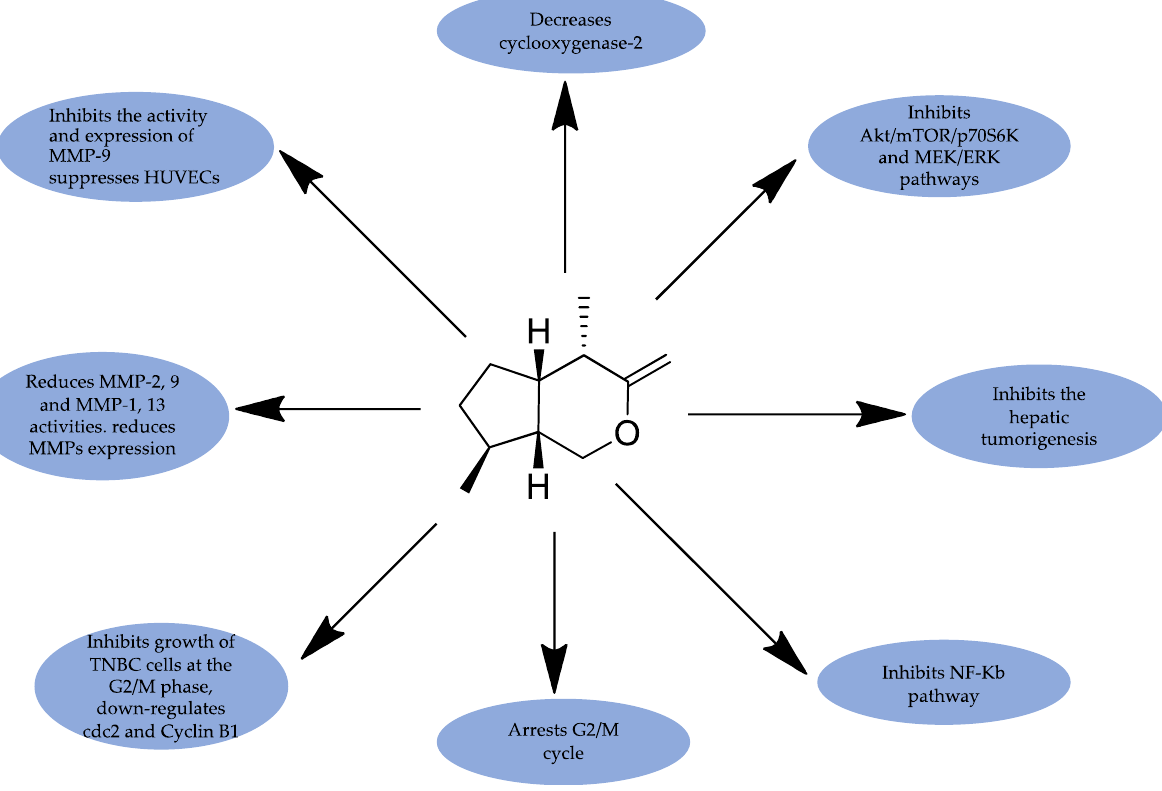
Figure 3. The basic structure of iridoids and their possible mechanisms of action in cancer management.